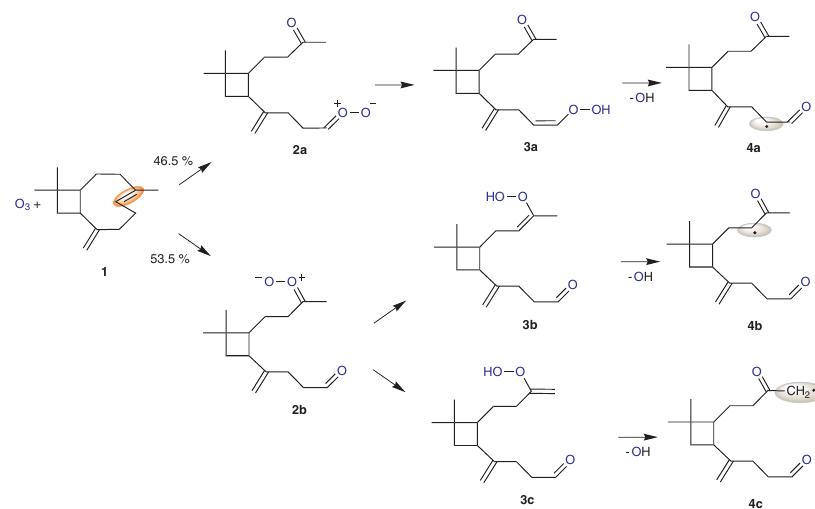
Figure 6. First reaction steps of the ozonolysis of β -caryophyllene. The attack of the more reactive endocyclic double bond (highlighted in orange) is exclusively demonstrated. Oxygen atoms arising from the attacking ozone are highlighted in blue, the alkyl radical functional groups with a shaded